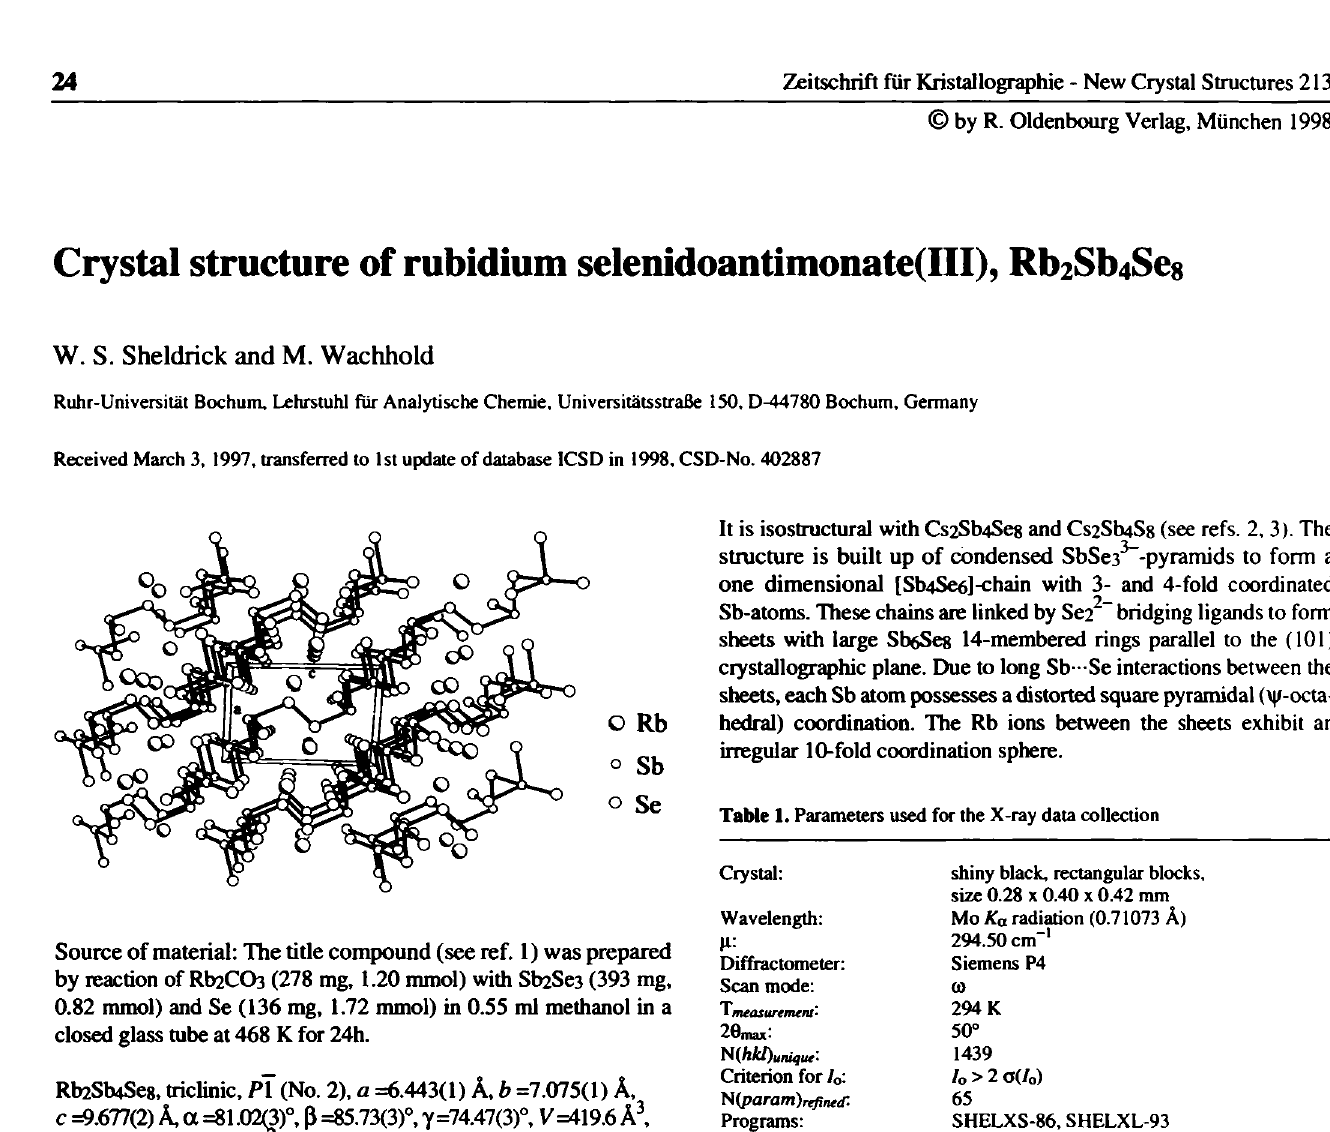
Table 2. Final atomic coordinates and displacement parameters (in